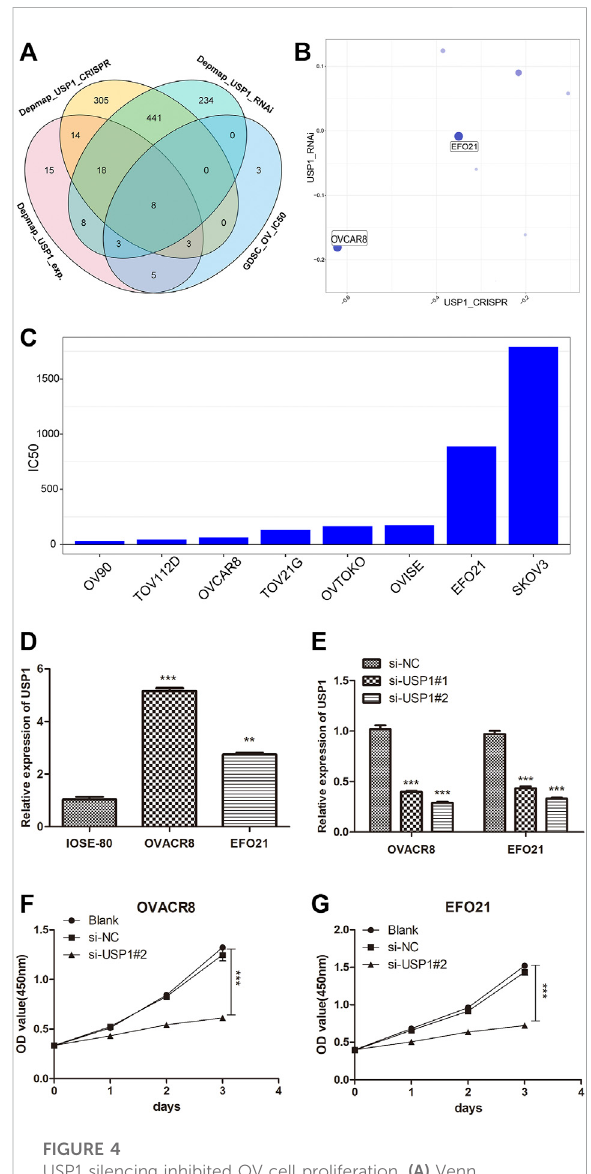
FIGURE 4 USP1 silencing inhibited OV cell proliferation. (A) Venn diagram of screening ovarian cancer cell lines. (B) Bubble diagram of combined CRISPR and RNAi evaluation of ovarian cancer cell lines. (C) HistogramofIC50valuesofovarian cancercelllines against the small molecule ML323. (D) USP1 expression levels in the normal ovarian cell line and ovarian cancer cell lines were detected by quantitative PCR. (E) Validation of OVACR8 and EFO21 cells with USP1 knockdown by qPCR. (F – G) Proliferation rate of OVACR8 and EFO21 cells detected by CCK-8